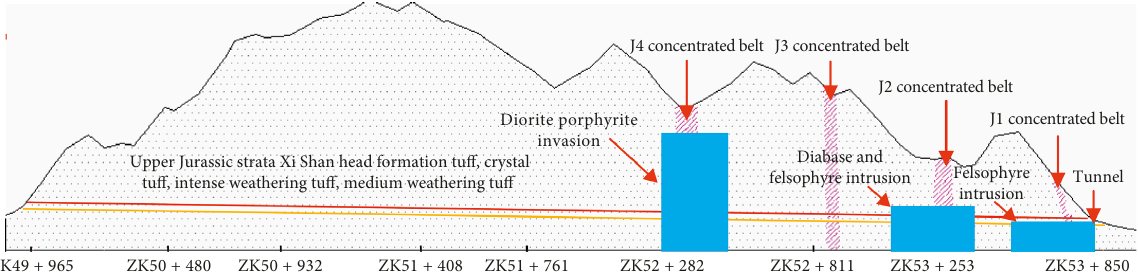
Figure 5: Geological longitudinal section of the Dashizi Tunnel and classification of the surrounding rock rupture zone. Anchor stress gauges